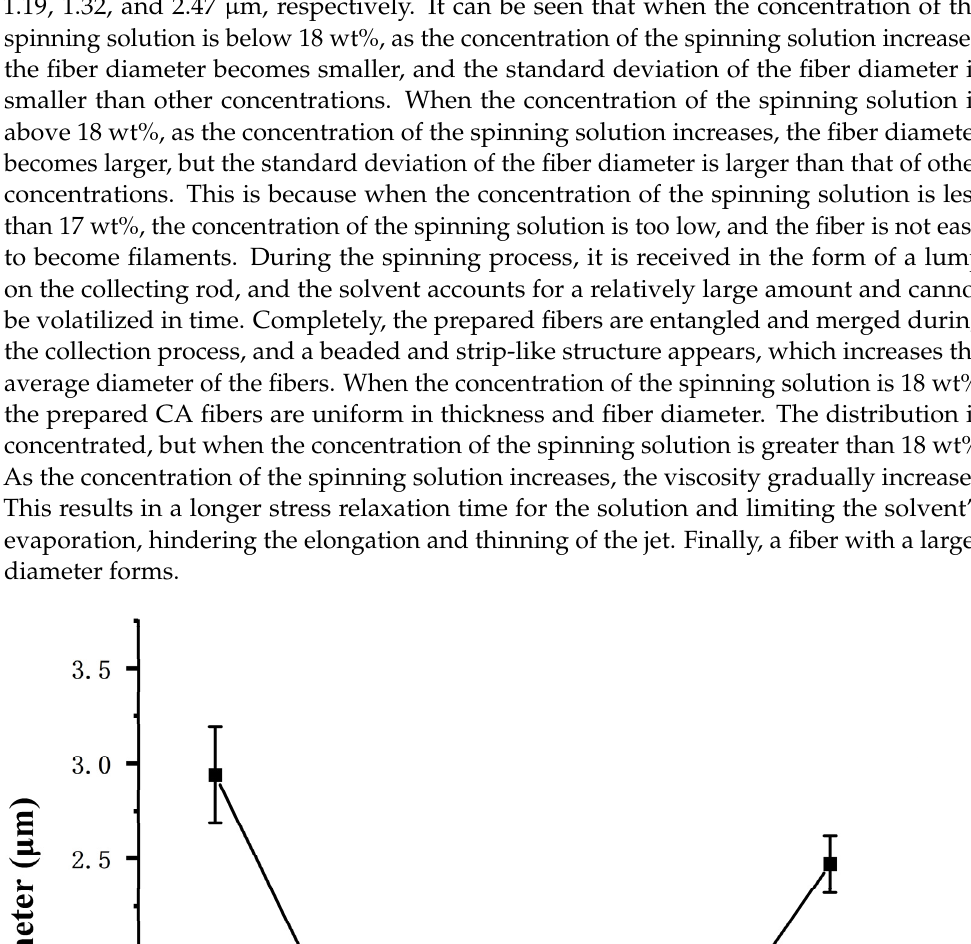
Figure 4. The variation curve of the viscosity of the spinning solution with the concentration.